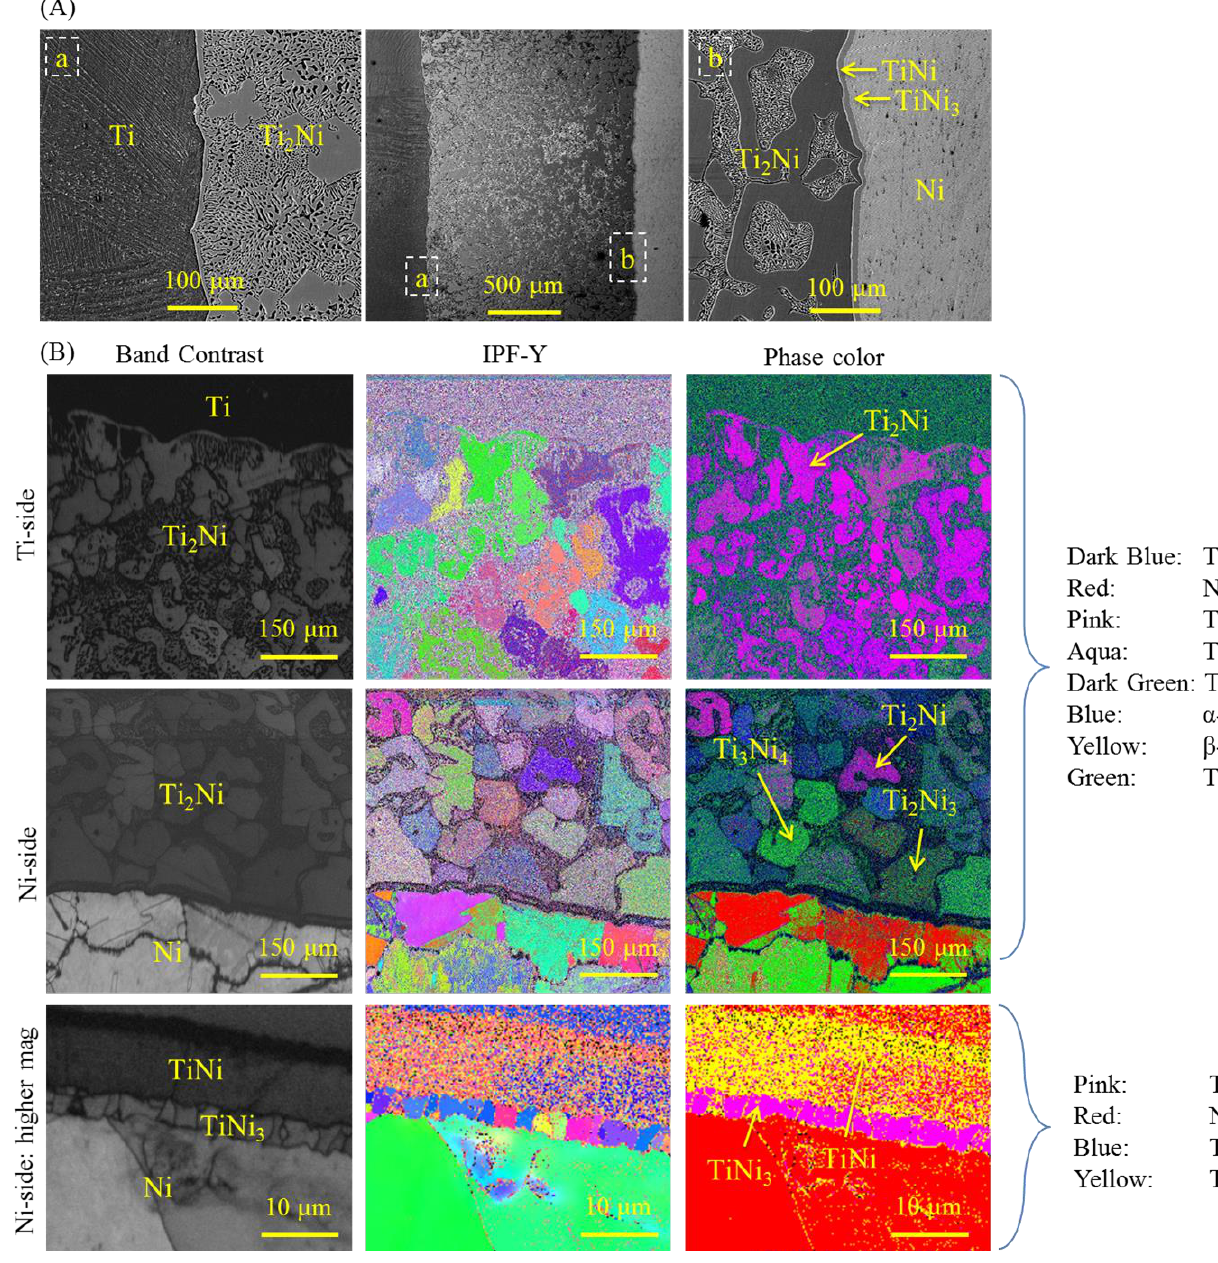
Figure 1. ( A ) SEM micrographs from the Ti – Ni diffusion couple annealed at 1173 K for 13 h (etched by Kroll’s reagent). ( B ) Electron backscattered diffraction from the Ti – Ni interface. The grain size distribution in the diffusion layers was observed in the EBSD results (Figure 1b) taken from both the Ti and Ni sides. Fine-grained Ti 2 Ni was formed close to the Ti side, while coarse mixed grains were formed on the Ni side. The unindexed areas close to the Ti side were attributed to the fine-grained structure of the Ti alloy. To elucidate the formation mechanism, it is crucial to identify the dominant diffusing element, determine the diffusion coefficients of the elements, and investigate the first intermetallic layer formed at the Ti–Ni binary system. The sequence of intermetallic compound formation at the Ti–Ni interface can be determined by calculating the Gibbs free energies of formation for the three compounds as a function of temperature